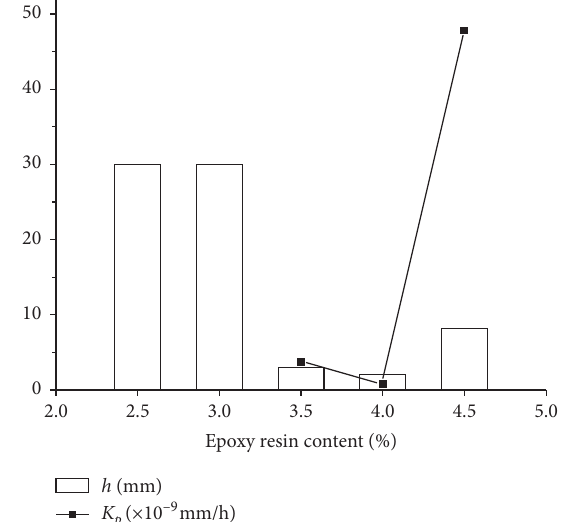
Figure 14: Values of penetration depth, h, and permeability coefficient, K